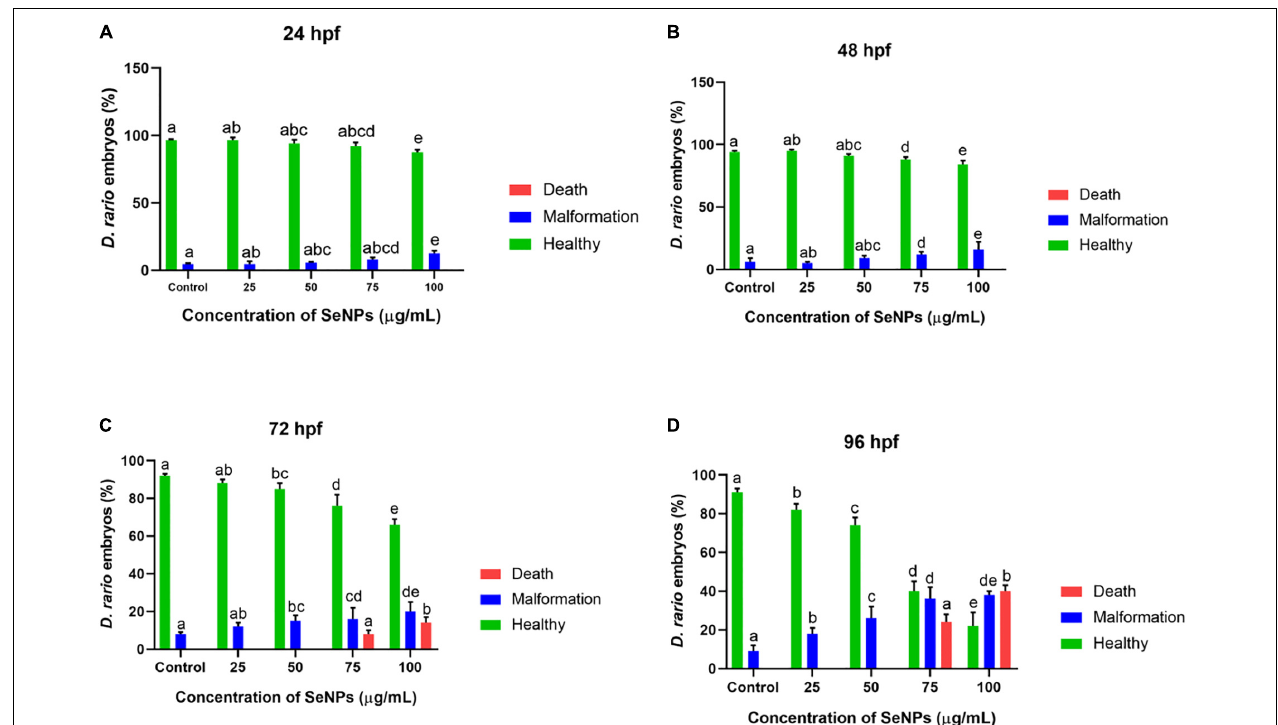
FIGURE 15 | Dose-dependent effect of SeNPs on malformation and death on D. rerio embryos at (A) 24, (B) 48, (C) 72, and (D) 96 hpf. The bar graphs with different letters within the particular analysis were significant ( p -value ≤ 0.05) by Tukey’s test.